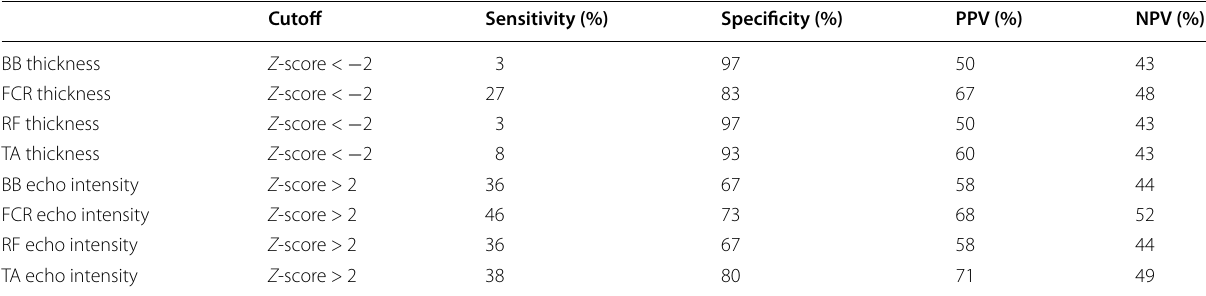
Table 3 Sensitivity, specificity, positive predictive value (PPV) and negative predictive value (NPV) for z-score cutoffs of 2 for muscle thickness and 2 for echo − +